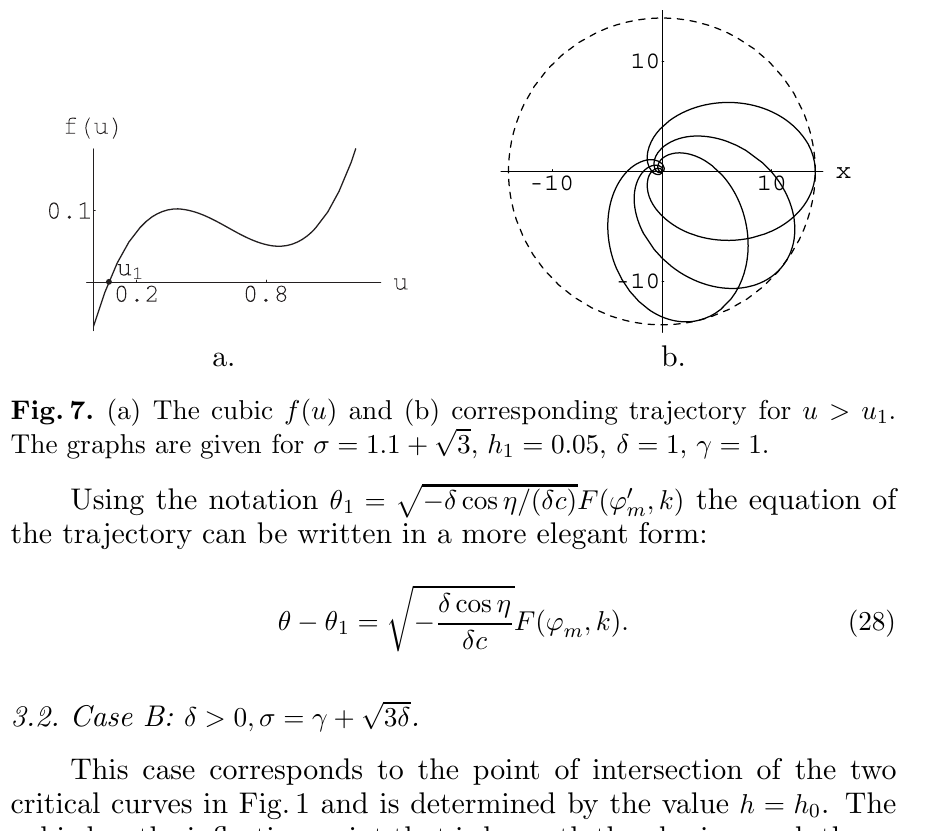
√ 3, h 1 = 0 . 05, δ = 1, γ =